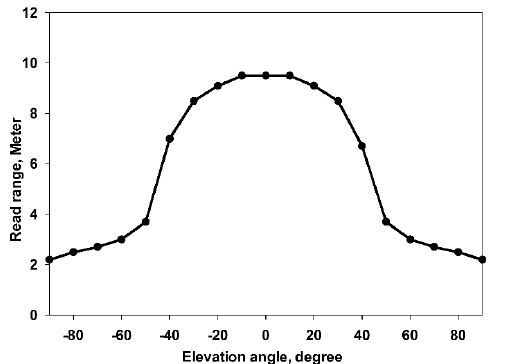
Figure 6a: Measured variations of reading range versus Elevation angle with θ =0 o for the RFID tag at 866 MHz